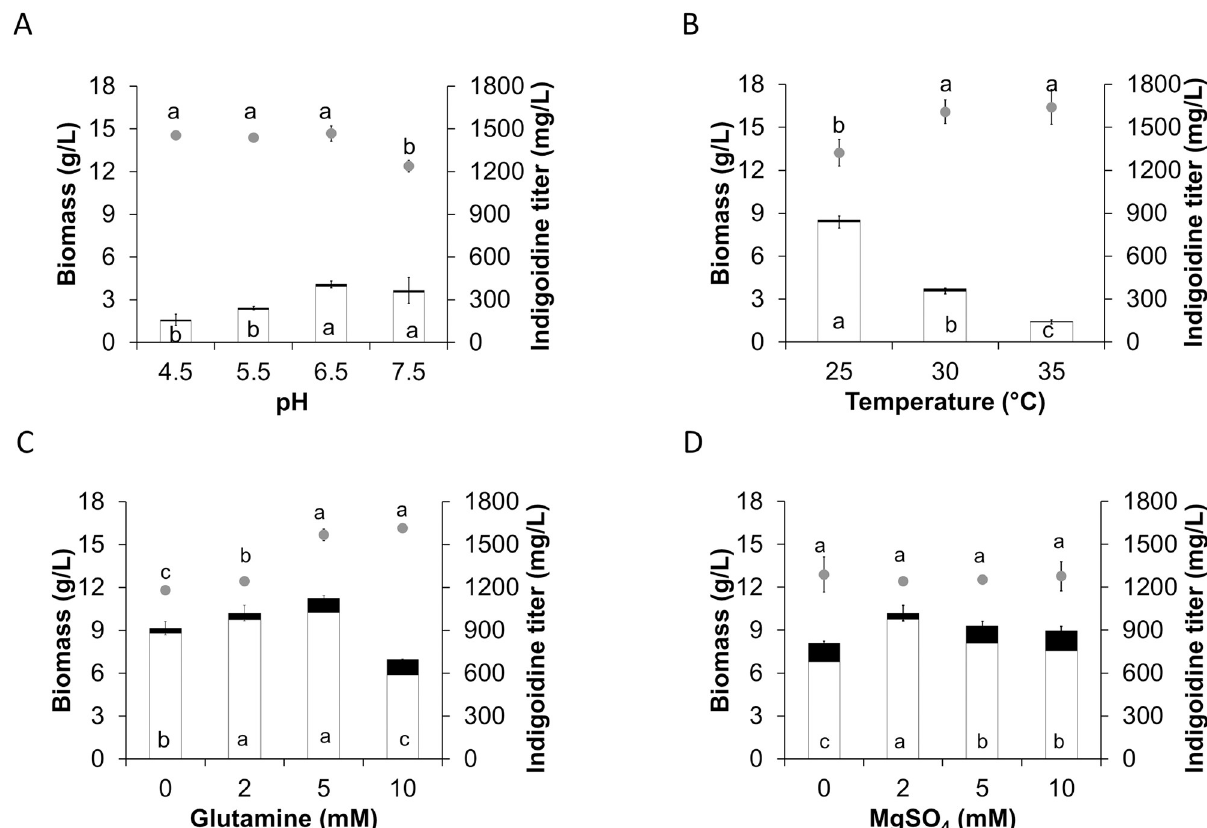
Fig 2. Effect of cultivation conditions on cell growth and InK production of the AoInK strain. All fungal cultures were grown in selective medium (SM) with agitation at 200 rpm for 5 d. Cultures grown with varying pH values at 30˚C (A). Fungal cultures grown at initial pH 6.5 at varying temperatures (B). Fungal cultures grown at initial pH 6.5 and then supplemented with varying concentrations of glutamine and incubated at 25˚C (C). Fungal cultures supplemented with 2 mM glutamine, grown at initial pH 6.5, and supplemented with varying MgSO 4 concentrations (D). Dry biomass (gray circle) and intracellular and extracellular InK titers (white and black bars, respectively) are shown. Letters above the symbol and inside the bars indicate the significant difference in dry biomass and total InK titers ( p < 0.05),